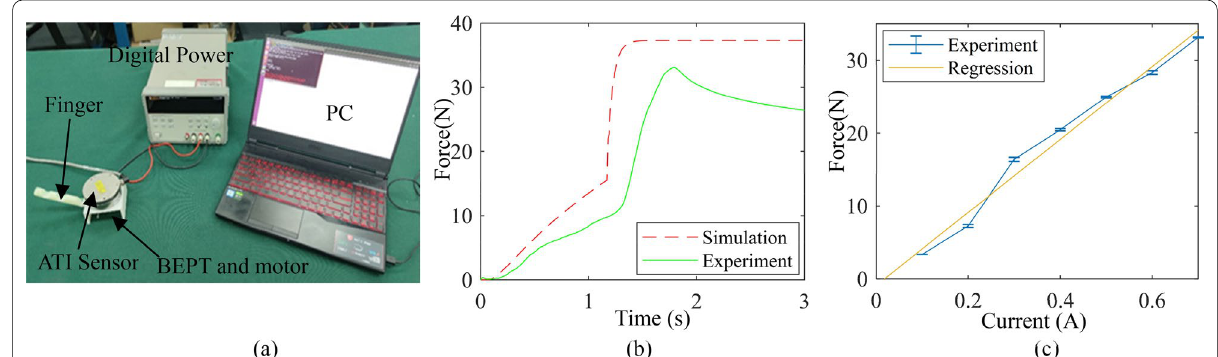
Figure 7 ( a ) Single finger experiment setting, ( b ) Comparison of fingertip force curve and simulation, ( c ) The relationship between fingertip force and current